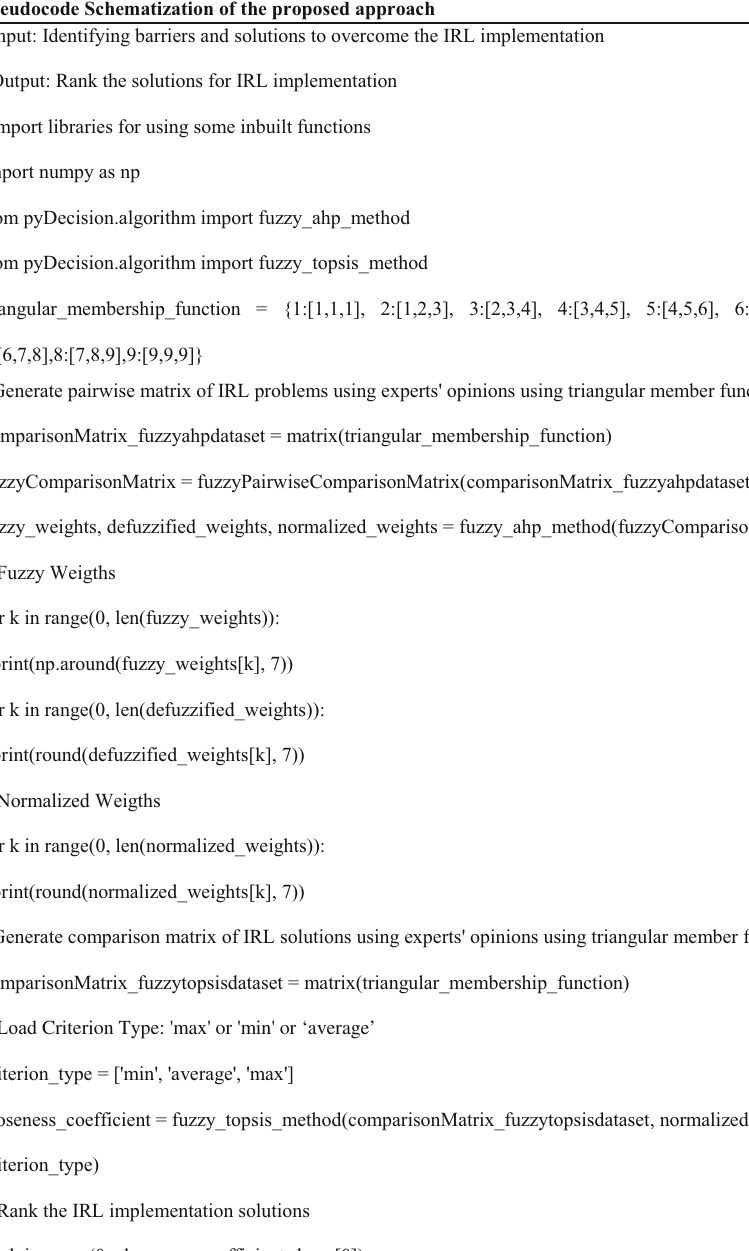
Pseudocode Schematization of the proposed